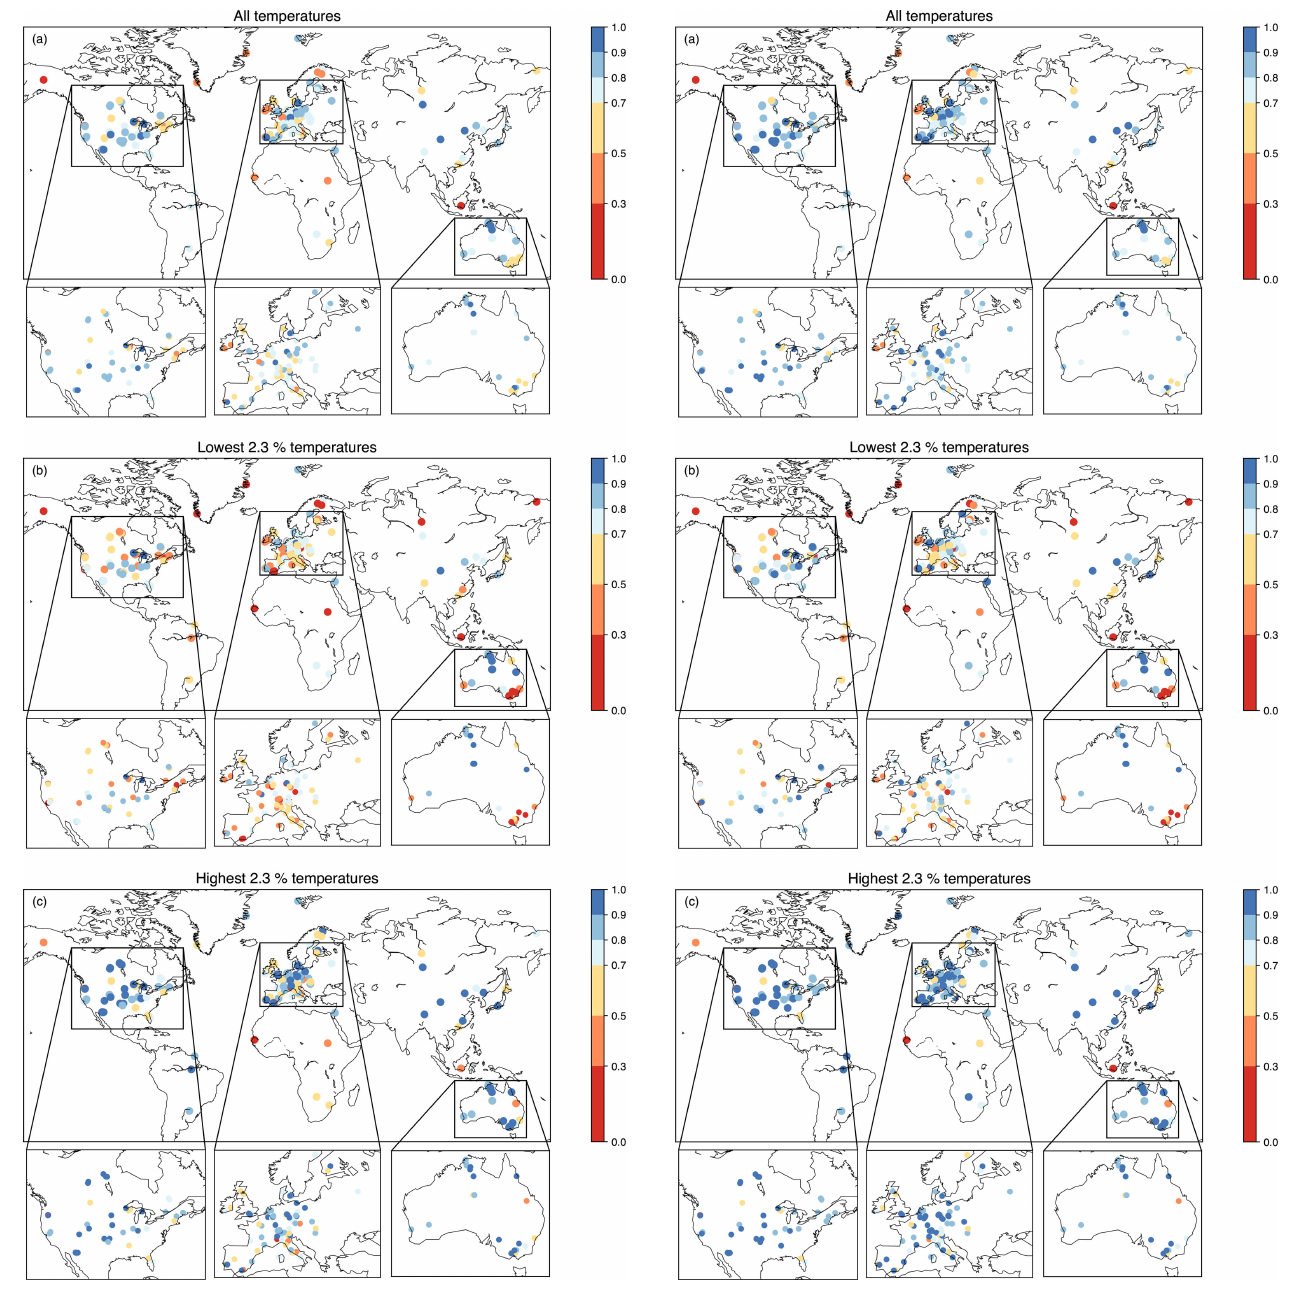
overall average is 0.42 compared to 0.79 for Q h and 0.73 for Q le . In terms of the overall metric (Fig. 4a), no sites exist with a ratio exceeding 0.9, and only one exceeds 0.8 Orv, US-Wi0) exceed 0.7 for the lower tail (Fig. 4b).